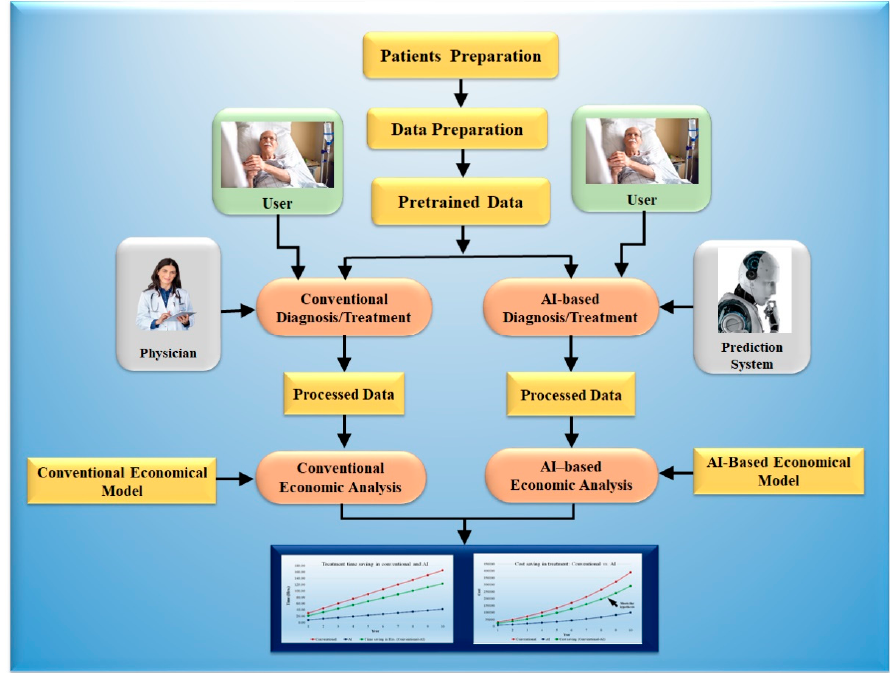
Figure 9. The AI economical model for the diagnosis and treatment against the conventional model.